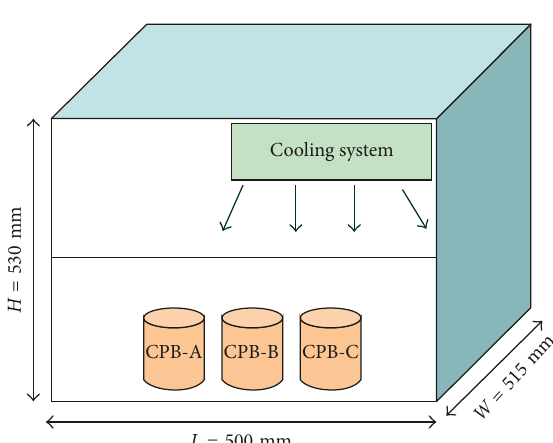
Figure 2: Schematic diagram of the refrigerator for the samples CPB-A, CPB-B, and CPB-C.